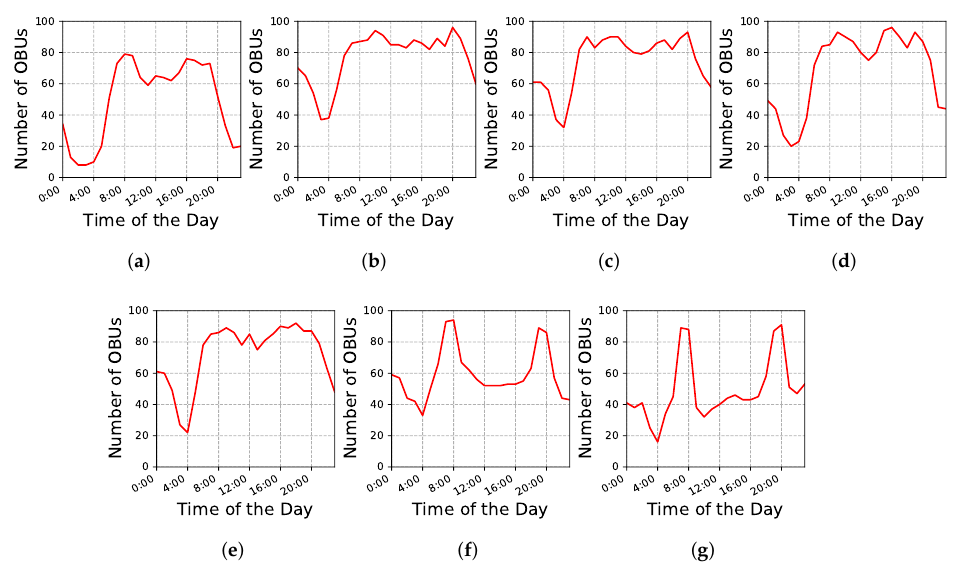
Figure 6. Scenario density along each day of trajectories extracted from the dataset.( a ) Monday; ( b ) Tuesday; ( c ) Wednesday; ( d ) Thursday; ( e ) Friday; ( f ) Saturday; ( g )